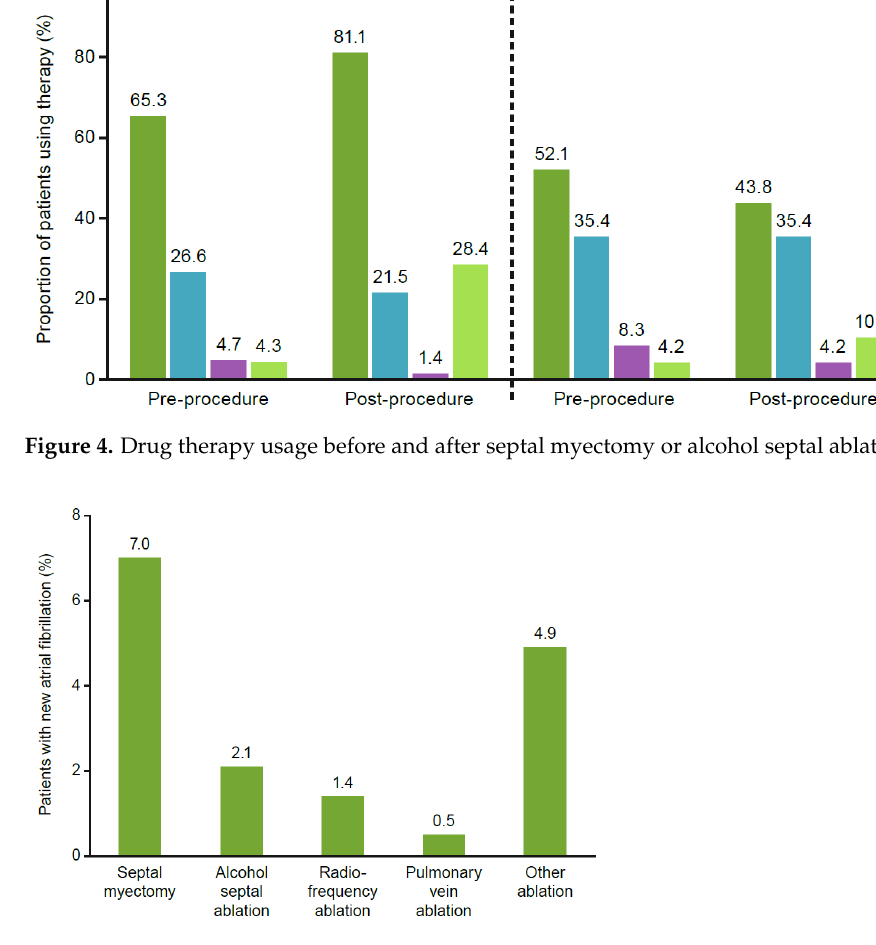
Figure 5. New-onset atrial fibrillation after procedures. New-onset atrial fibrillation is defined as >3 months after procedure. Percentages indicate the proportion of all patients who received a procedure.